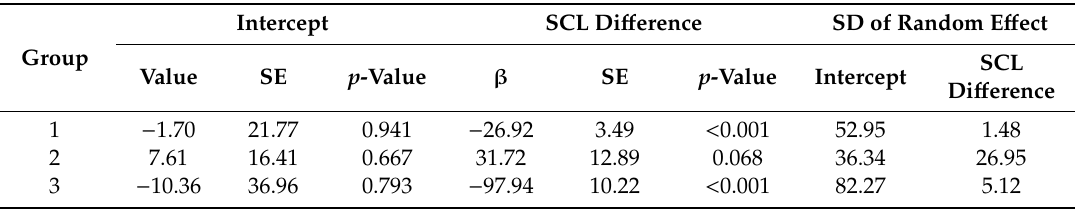
Table 1. Linear mixed models of Elo-score di ff erence on the SCL di ff erence at the interaction level for the three groups of hatchling European Pond Turtles. The identity of the winning individual was used as a random e ff ect for both the intercept and SCL Di ff erence; SD: standard deviation of the random e ff ect.